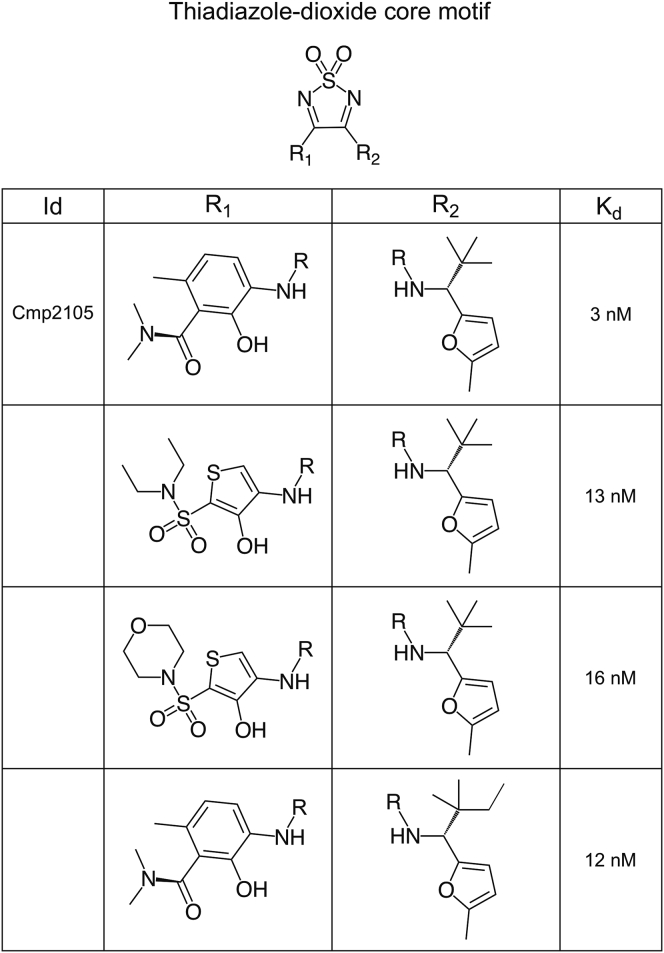
Related to Figure 2 and 3Cmp2105 belongs to a set of four CCR7 binding molecules orginating from a large group of thiadiazole-dioxides developed and patented as potent ligands for chemokine receptors. They contain a thiadiazole-dioxide core motif with a characteristic sulfonyl group. Modification of the two amine-linked exit vectors of the central motif allows to fine-tune binding toward CCR7 (dissociation constants [Kd] taken from Taveras et al., 2010).